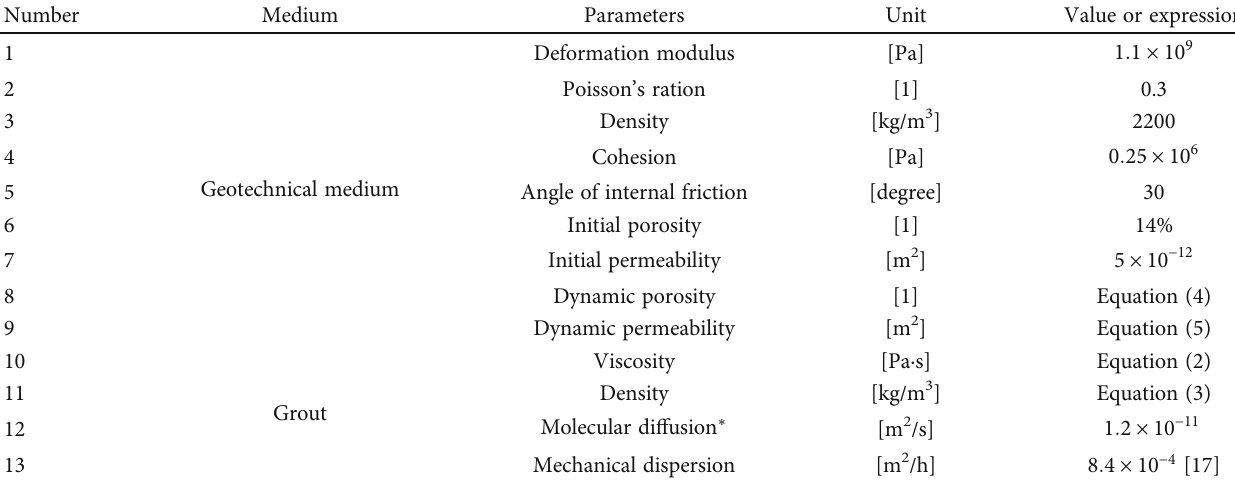
Table 3: Value of parameters in the numerical model.